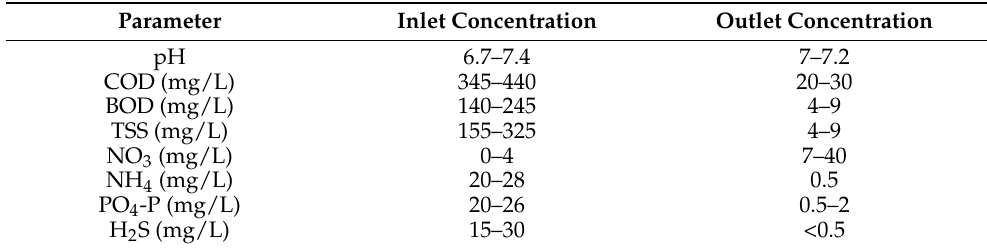
Table 2. The performance of Karbala sewage treatment plant.